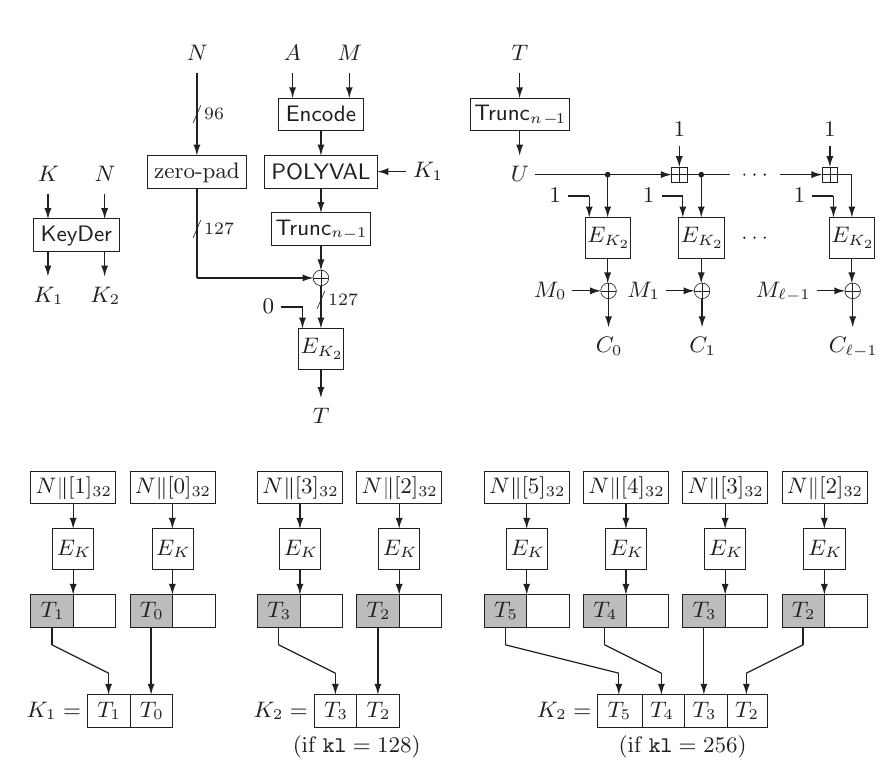
Figure 1: The AES - GCM - SIV mode (top) and the key derivation function (bottom). in n -bit blocks ( M 0 , . . . , M ‘ − 1 ) where ‘ = d| M | /n e , | M i | = n for i ∈ { 0 , . . . , ‘ − 2 } ,